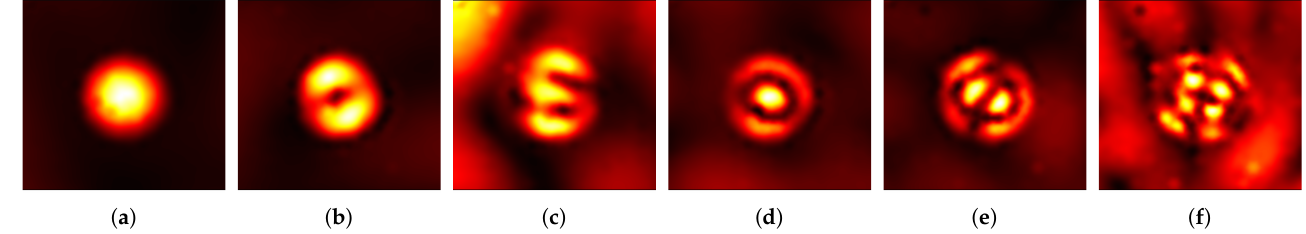
Figure 11. Different vibration modes of the middle left rivet (area I) for the fundamental frequency ( a ) 25 ( 1 ) kHz and higher harmonics ( b – f ) 51kHz, 76kHz, 89kHz, 125kHz and 169kHz. Additional vibration patterns are shown in Reference